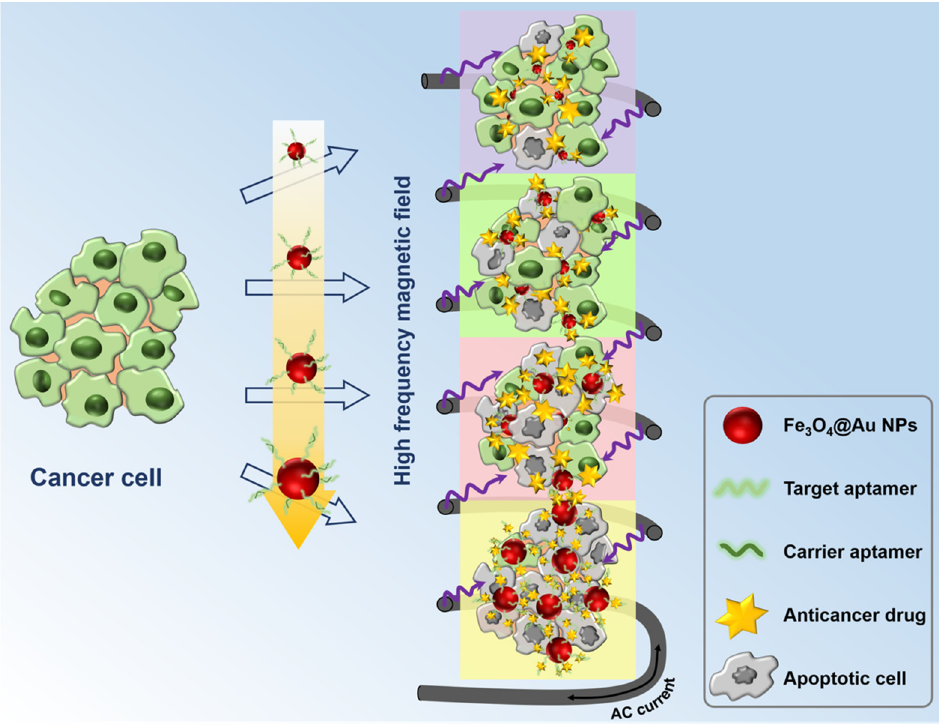
Scheme 1. Schematic illustration of the synthesis of the multifunctional molecule delivery system and its further applica-